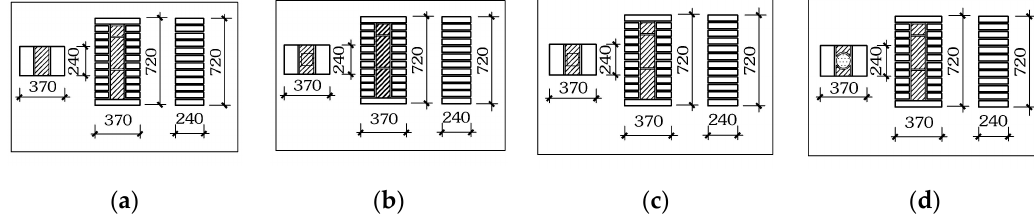
Figure 2. Dimensions and structural details for specimens with 240 mm × 370 mm cross section: ( a ) standard specimen; ( b ) square ‐ shaped wood embedded; ( c ) square ‐ shaped steel pipe embedded; and ( d ) circular steel pipe embedded. Table 1. Specifications. Group No. Specimen